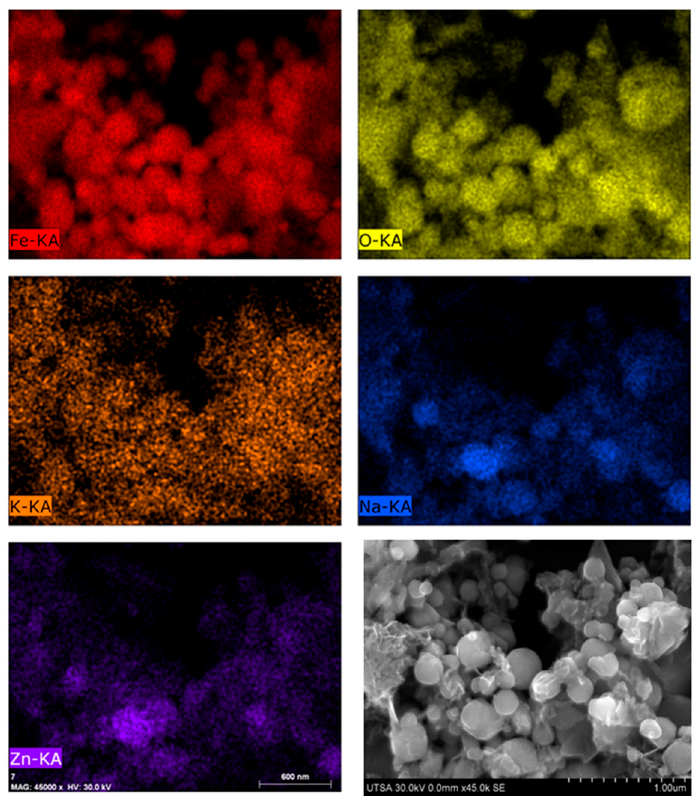
Figure 3. SEM element mapping of BFS.